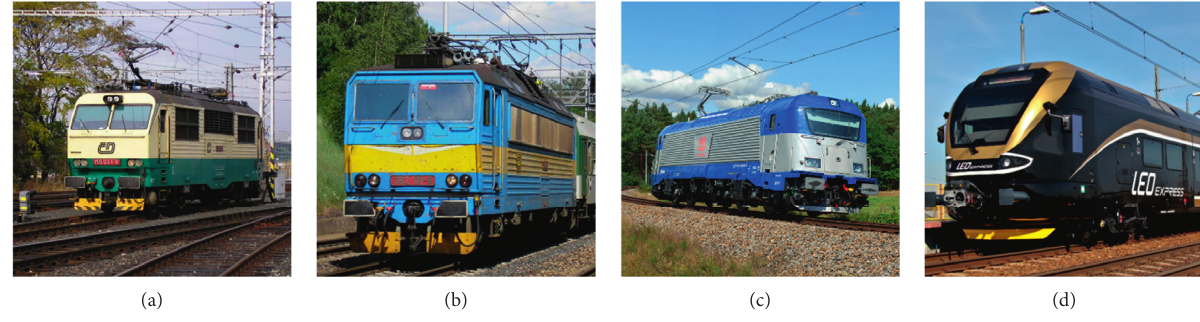
Figure 5: Train types: (a) 151, (b) 362, (c) 380, and (d) Leo